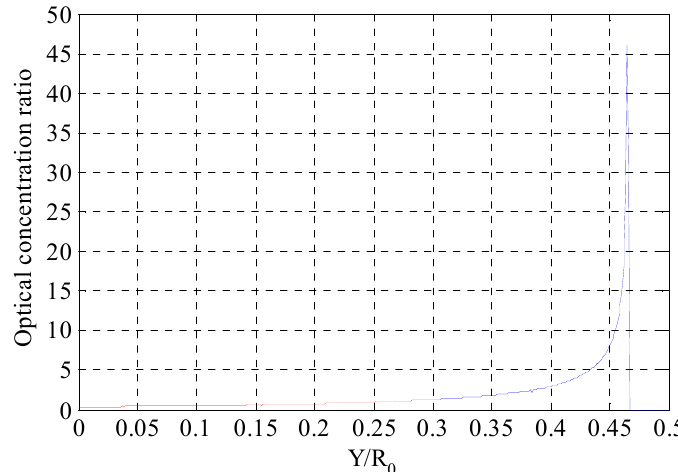
Figure 6. Original power distribution on the cell array. Table 2. Original optical parameters. Ave. Dev. Min.